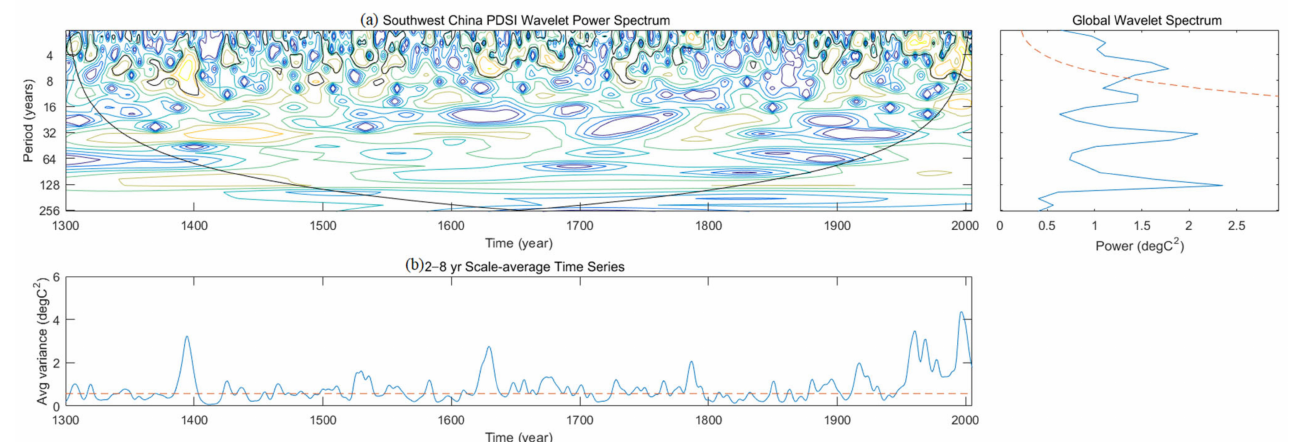
Figure 4. Periodicity analysis results of the PDSI series. ( a ) Wavelet power spectrum; the thick black contour in the left part designates the 95% confidence level against red noise, and the cone of the influence (COI) where the edge effects might distort the picture is shown as a lighter shade; the imaginary line in the right part designates the 95% confidence level for a red noise null hypothesis; if the peak value of full line exceeds the imaginary line in the power map, then the corresponding period is significant. ( b ) Singular spectrum amplitude of PDSI series variations for a period of 2–8 years, identified as the most significant oscillation mode (9% of the total variance associated with this waveform).